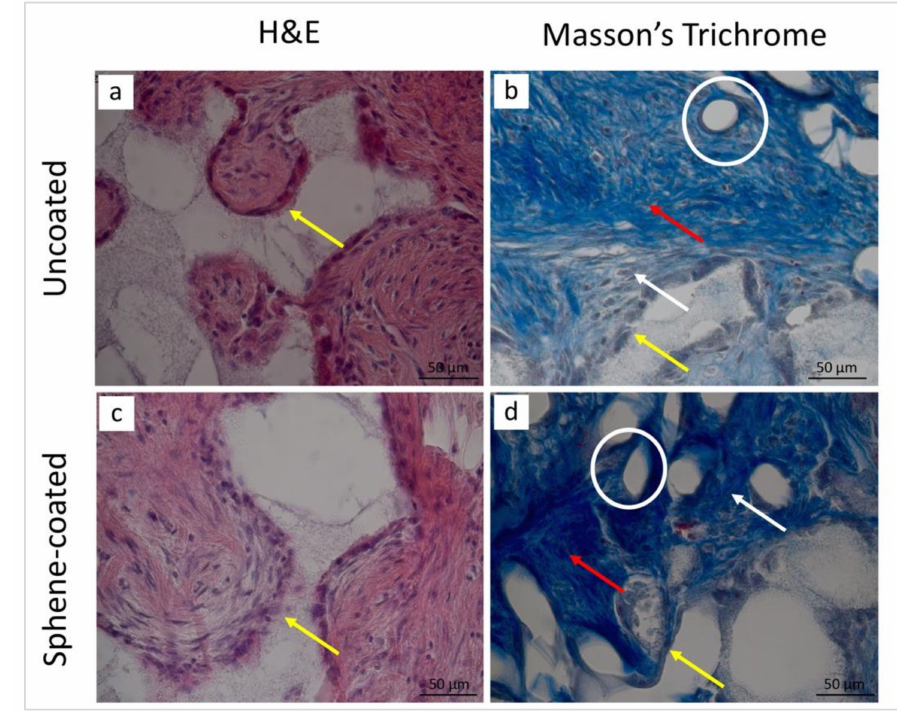
Figure 11. Staining with H&E ( a , c ) and Masson’s trichrome ( b , d ) of the peri-implant tissues around the uncoated ( a , b ) and the sphene-coated implants after 28 days of healing. In both experimental conditions, fibroblasts (white arrows), collagen fibers (red arrows), as well as vessels (white circles) could be observed. Moreover, osteogenic cells (yellow arrows) were